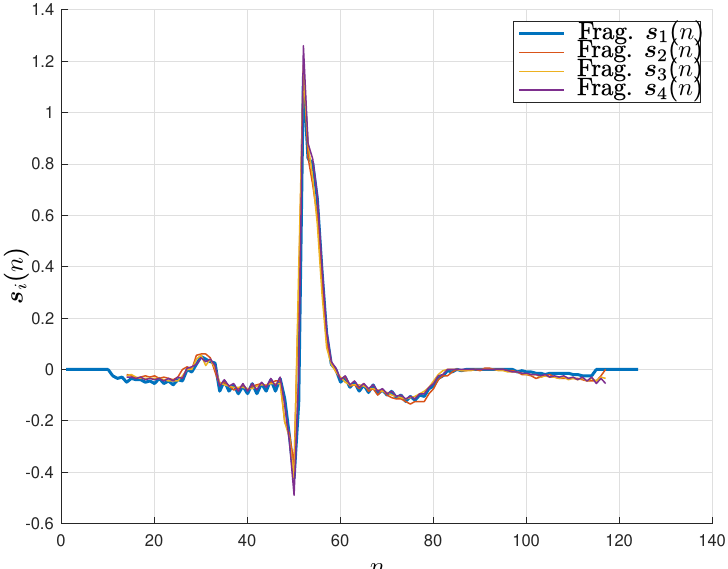
Figure 5. The example alignment of four fragments, each containing exactly one R-peak. Sleep Apnea Detection in the ECG